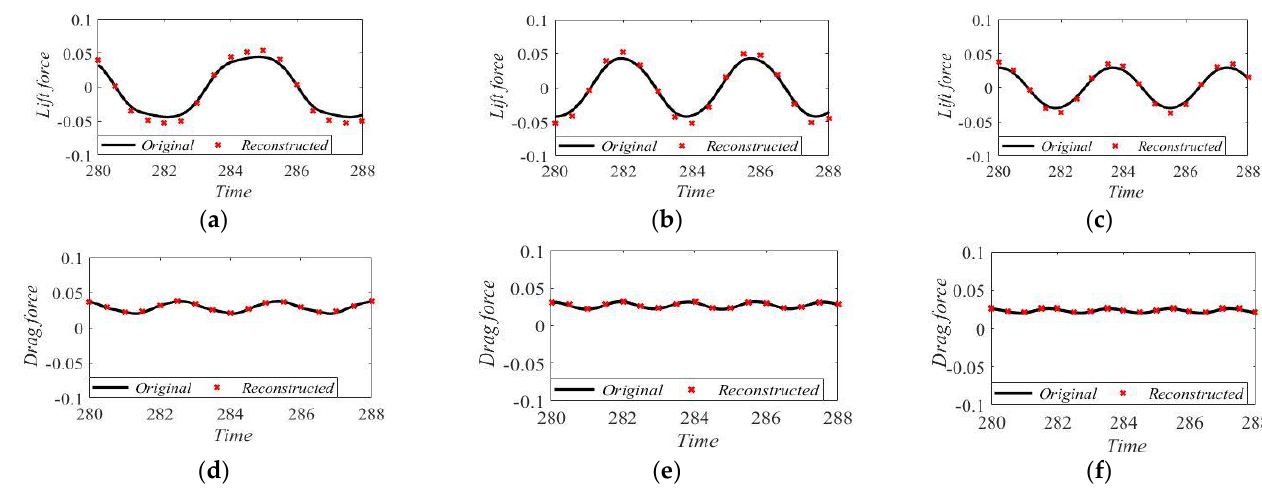
Figure 21. Time histories of ( a – c ) the UC lift coefficient and ( d – f ) drag coefficient obtained by the simulation results and reconstructed by using the selected DMD modes for L / D = 1.8, 2.5 and 3: ( a , d ) L / D = 1.8; ( b , e ) L / D = 2.5; ( c , f ) L / D = 3.